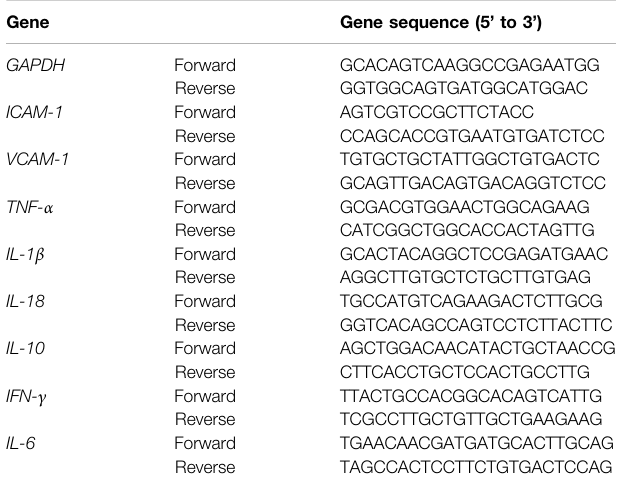
TABLE 3 | Primers sequences. Gene Gene sequence (5 ’ to 3 ’